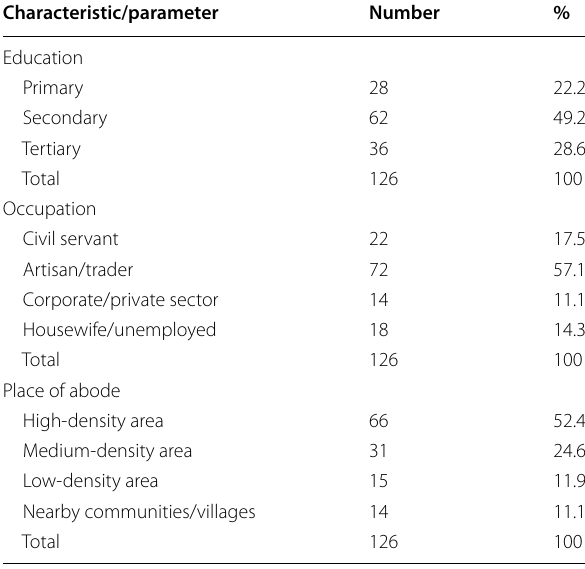
Table 1 Victims’ characteristics Table 2 Characteristics of victims’ custodian (parent/guardian)